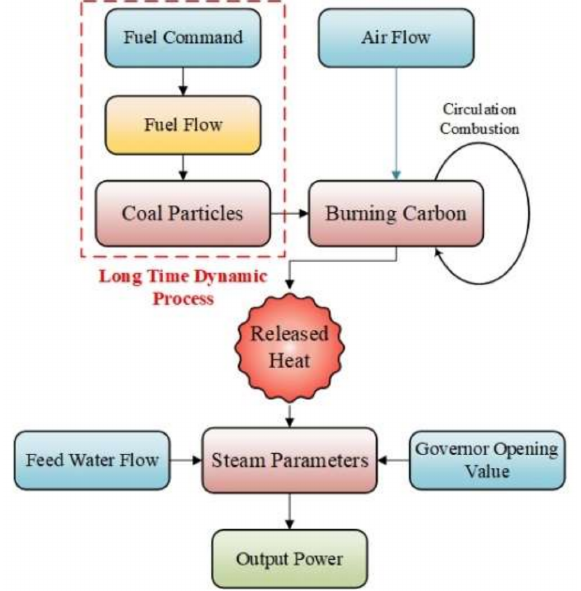
Figure 2. Factors affecting the released heat of the furnace in the CFB boiler